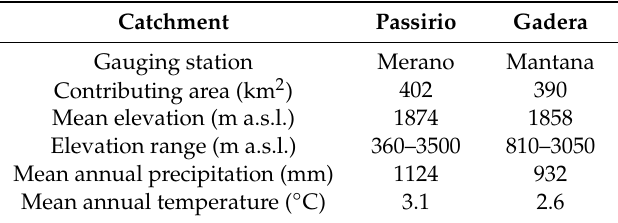
Table 1. Main characteristics of the two case